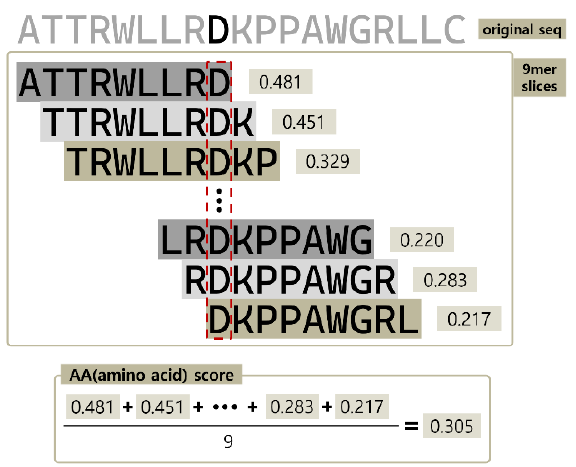
Figure 4. Calculation of Residual cell-penetrating propensity.